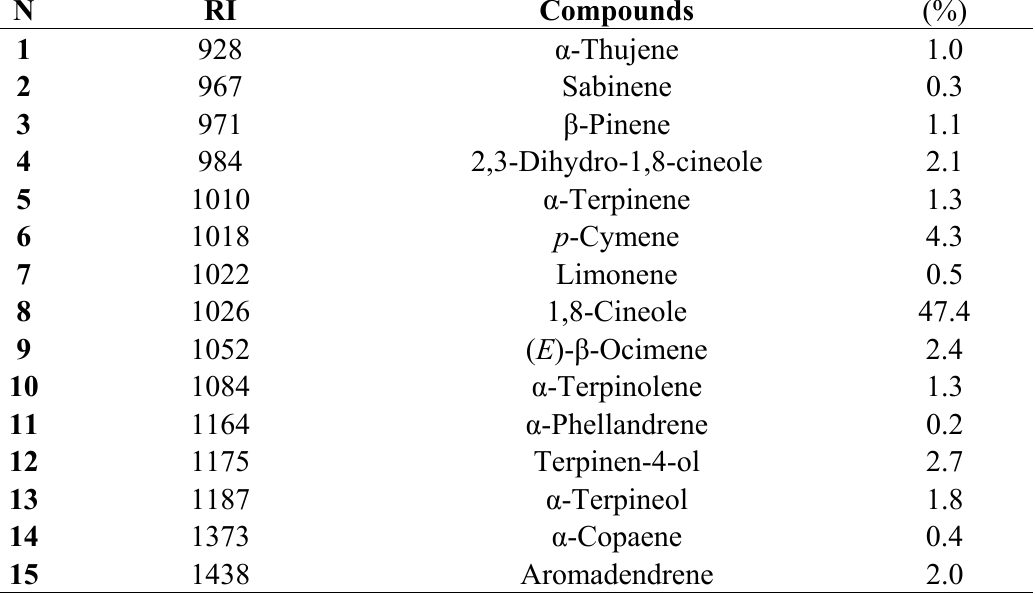
Table 1. Chemical composition of H. gymnocephalum essential